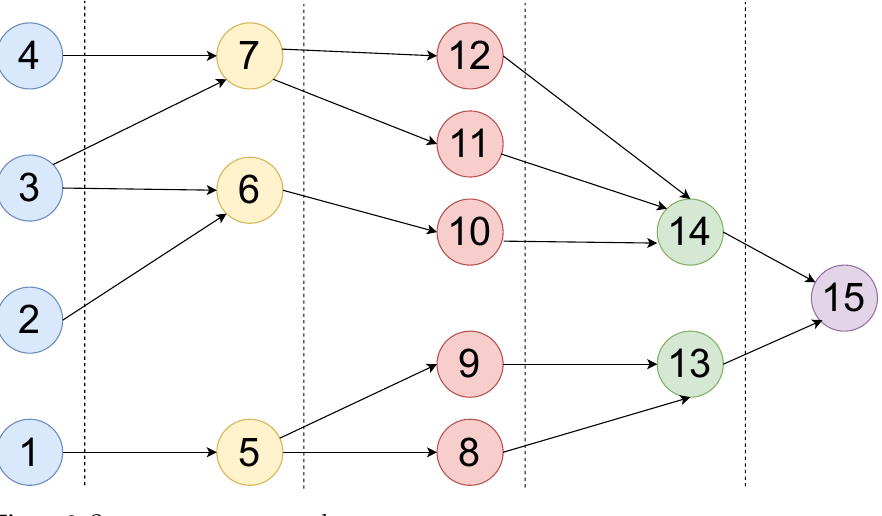
Figure 2. Structure-aware